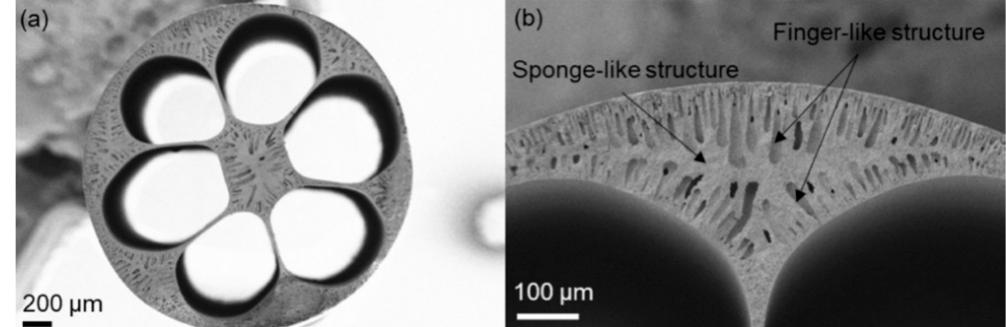
Figure 10. Cross-sections of a 6-channel µT-SOFC cell with optimised microstructure [103]. ( a ) overall cross-section, ( b) zoom of